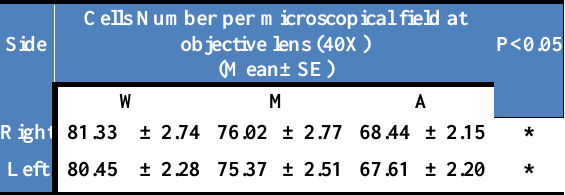
Table, 1: Number of sensory neurons at L6 level of rabbit's spinal